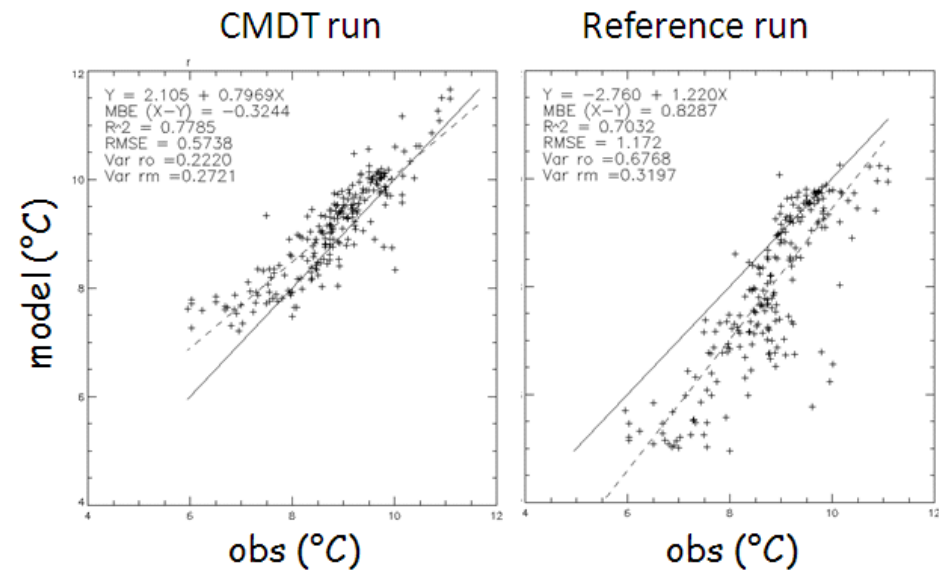
Figure 6: Scatter plot of model temperatures versus XBT temperatures between 100 and 500m for the CMDT run (left) and the Fig. 6. Scatter plot of Mercator model temperatures versus observational profile temperatures between 100 and 500m for the CMDT run reference run (right) in the subpolar gyre. (left) and the reference run (right) in the subpolar